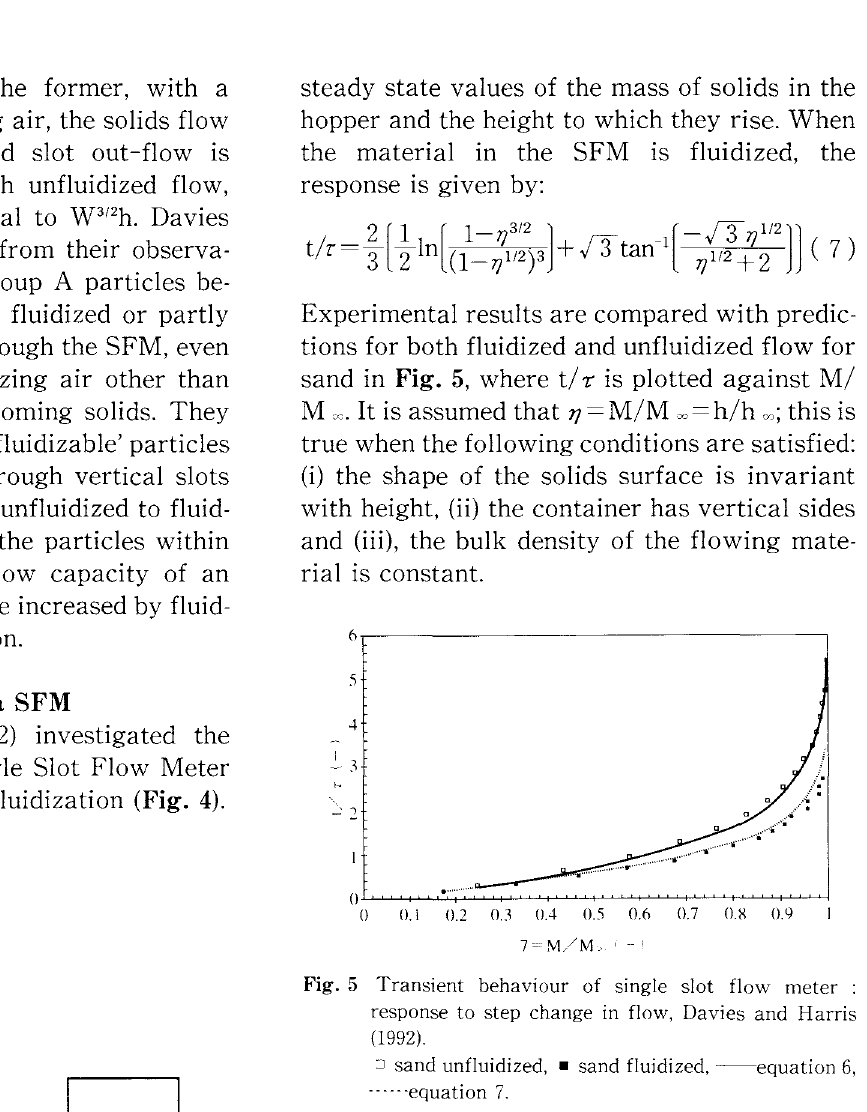
Fig. 5 Transient behaviour of single slot flow meter : response to step change in flow, Davies and Harris (1992). :J sand unfluidized, • sand fluidized, -equation 6, ------equation